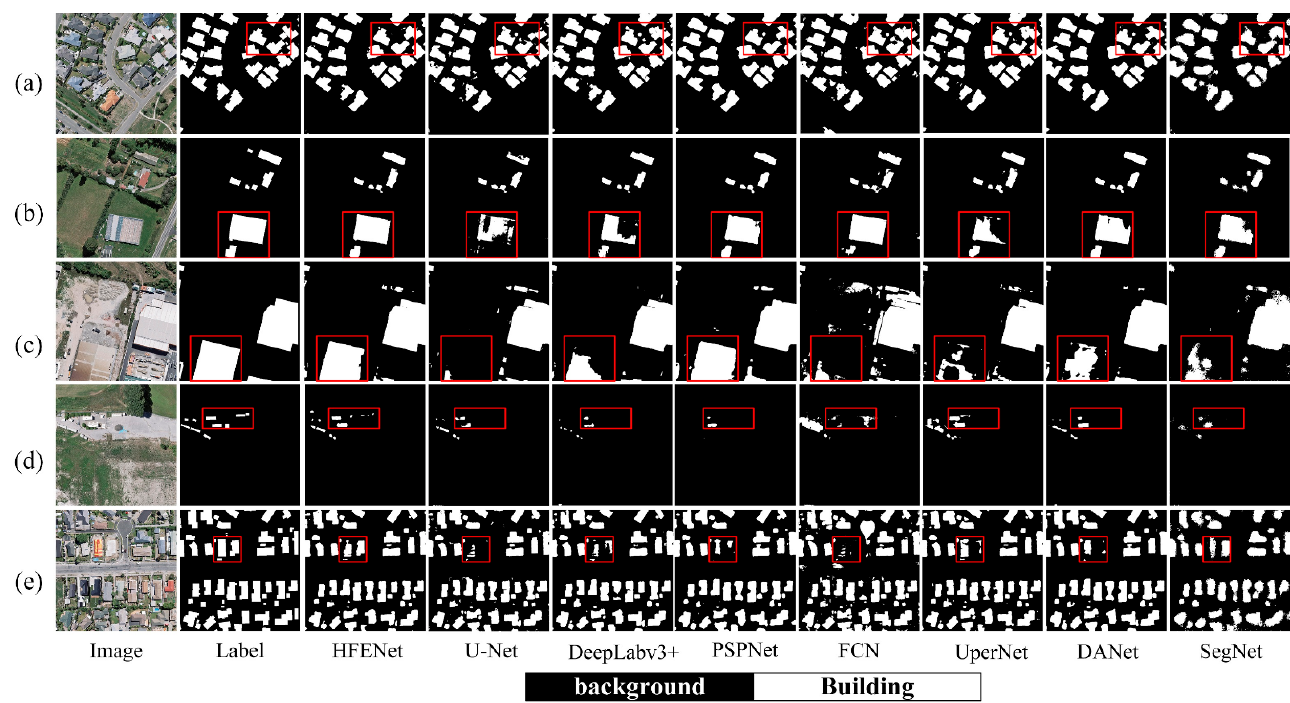
Figure 10. Visualization comparison of classification results of different state-of-the-art models on the WHU building dataset. ( a – d ) respectively shows the different cases of inaccurate classification caused by large scale difference of objects. ( e ) shows the inaccurate classification in complex scenes with large differences in features.